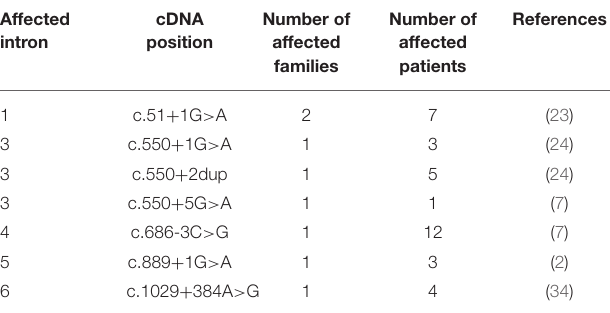
TABLE 4 | Intronic mutations identified in the SERPING1 gene.